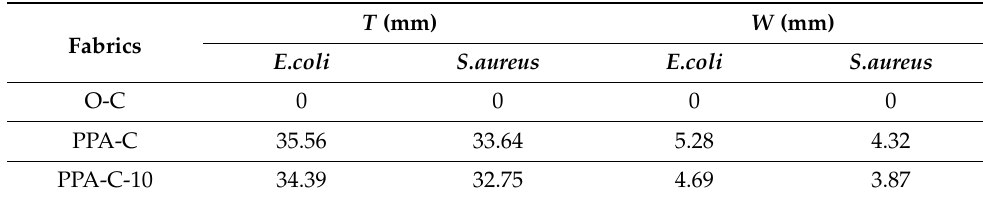
Table 2. Antibacterial width of fabrics.